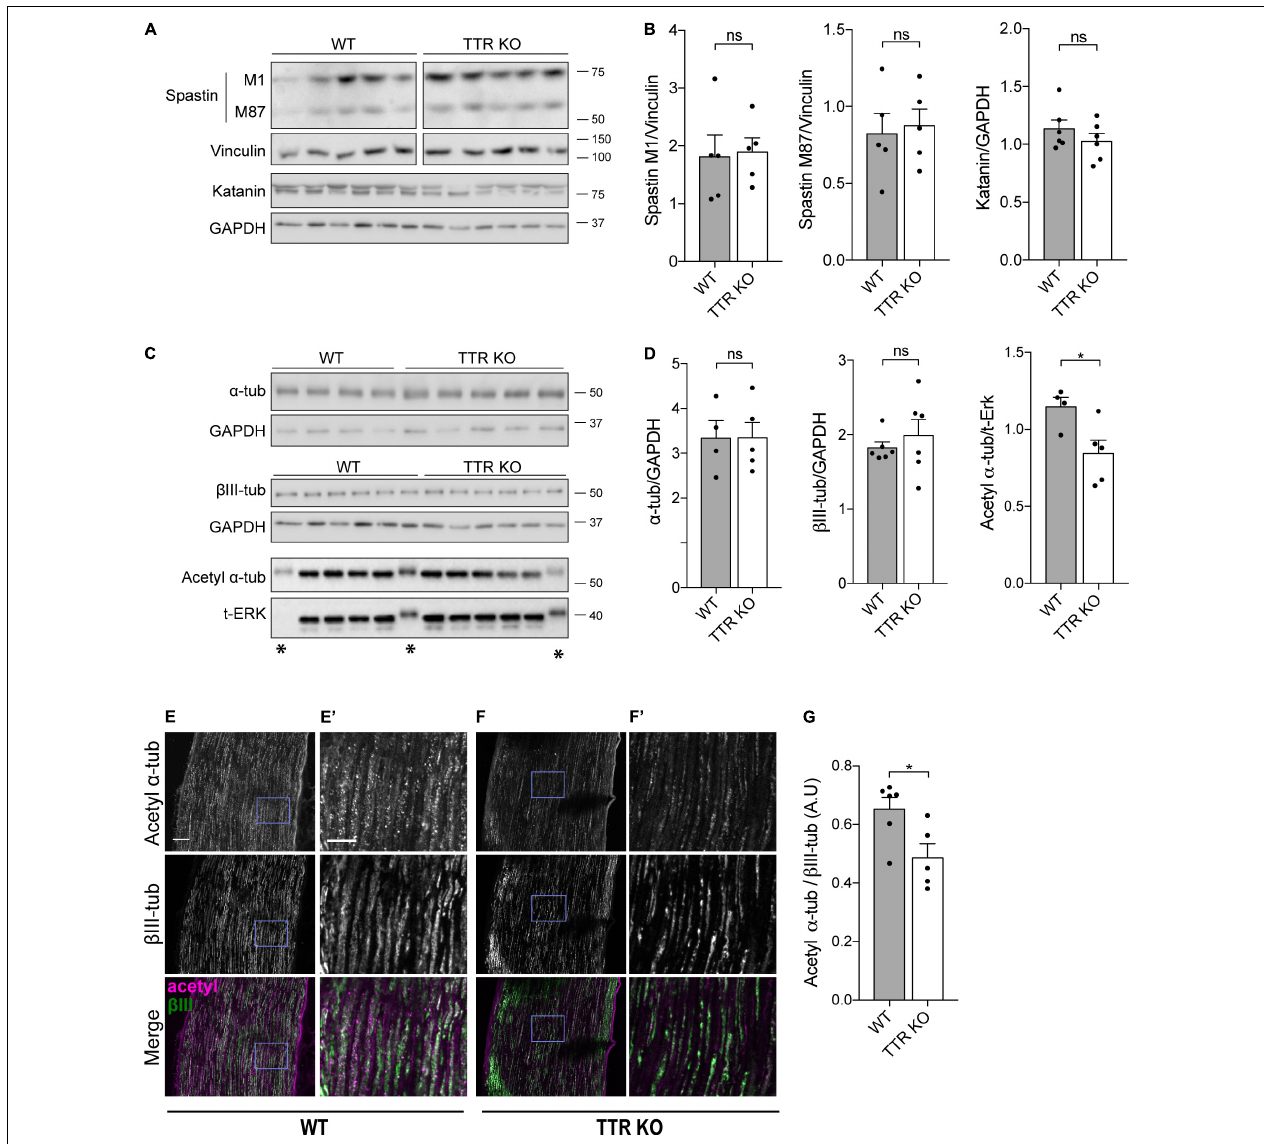
FIGURE 3 | Transthyretin KO sciatic nerve axons have decreased levels of α -tubulin acetylation. (A,B) Western blot analysis (A) and respective quantification (B) showing MT severing enzyme levels in sciatic nerves of 12-weeks-old WT and TTR KO mice. Vinculin or GAPDH were used as loading controls. Data represent mean ± SEM ( n = 5–6 animals/condition). ns – not significant by Student’s t -test. (C,D) Western blot analysis (C) and respective quantification (D) showing α -tubulin, β III-tubulin, and acetyl α -tubulin levels in sciatic nerves of 12-weeks-old WT and TTR KO mice. GAPDH or ERK were used as loading controls. *Bands presenting an altered running pattern were not quantified. Data represent mean ± SEM ( n = 4–6 animals/condition). Statistical significance determined by Student’s t -test: * P < 0.05. ns, not significant. (E,F) Representative images of 12-weeks-old WT (E) and TTR KO (F) sciatic nerves immunostained for acetylated α -tubulin and β III-tubulin. Scale bar: 50 µ m. (E’,F’) Zoomed in regions from panels (E,F) , respectively. Scale bar: 20 µ m. (G) Quantification of the relative values of acetylated α -tubulin over β III-tubulin. Data represent mean ± SEM ( n = 5–6 animals/genotype, 45–57 axons/animal). Statistical significance was determined by Student’s t -test: * P <